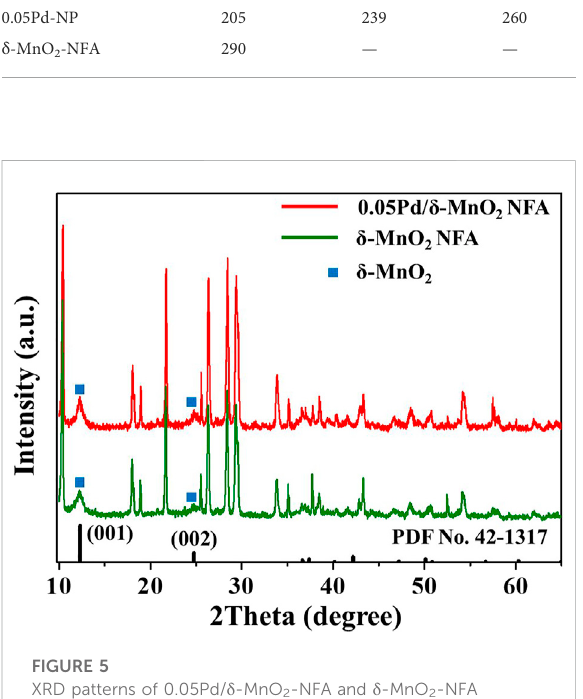
FIGURE 5 XRD patterns of 0.05Pd/ δ -MnO 2 -NFA and δ -MnO 2 -NFA samples.